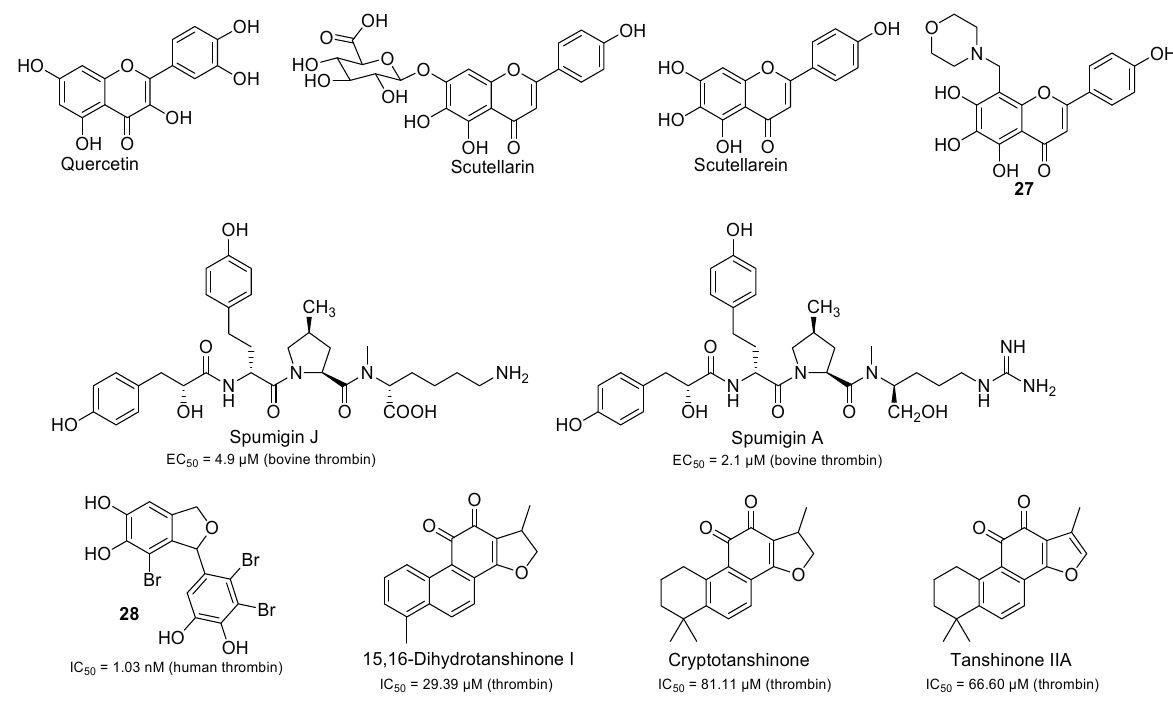
Figure 6. The chemical structures of natural products and their derivatives as thrombin inhibitory